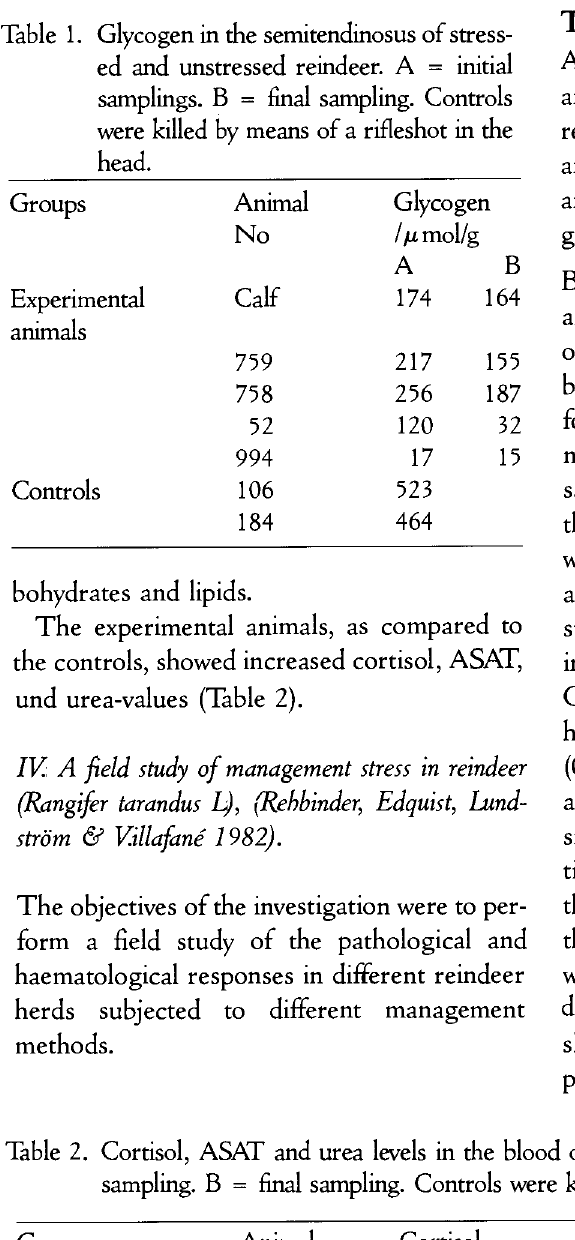
Table 2. Cortisol, ASAT and urea levels in the blood of stressed and unstressed reindeer. A = initial sampling. B = final sampling. Controls were killed by means of a rifleshot in the